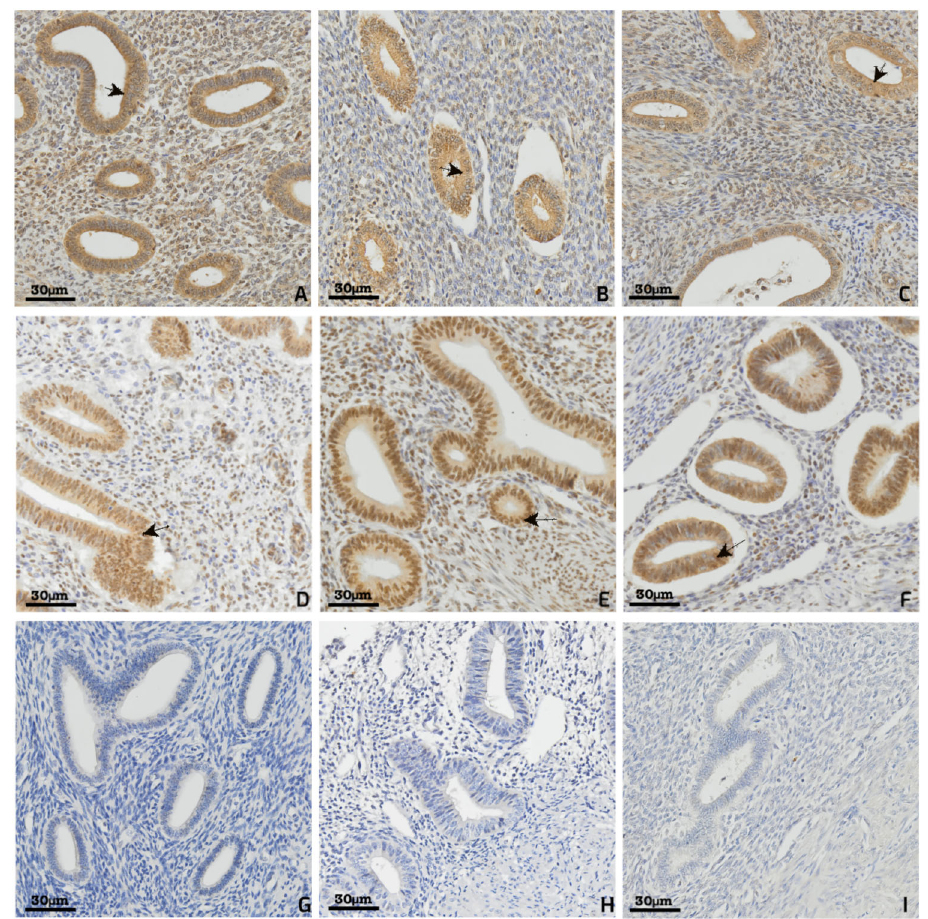
Figure 2. Immunohistochemical expression of Drosha, Exportin, and Dicer. Drosha in eutopic endometrium, without adenomyosis ( A ), in eutopic endometrium with adenomyosis ( B ), and in ectopic endometrium ( C ). Exportin in eutopic endometrium without adenomyosis ( D ), in eutopic endometrium with adenomyosis ( E ), and in ectopic endometrium ( F ). Dicer in eutopic endometrium without adenomyosis ( G ), in eutopic endometrium with adenomyosis ( H ), and in ectopic endometrium ( I ). Scale bars, 30 m m. Arrows represent luminal columnar epithelial cells that make up endometrial glands. A predominant pattern of cytoplasmic staining for the anti-Drosha antibody and both a nuclear and cytoplasmic pattern for the anti-Exportin antibody was